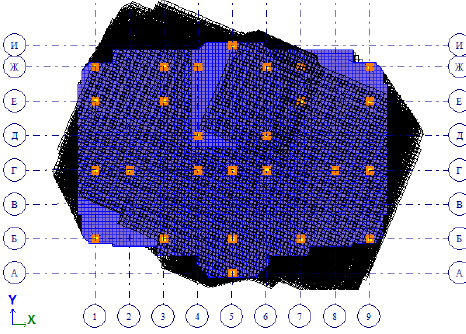
Fig. 2. The first form of vibrations of the building -